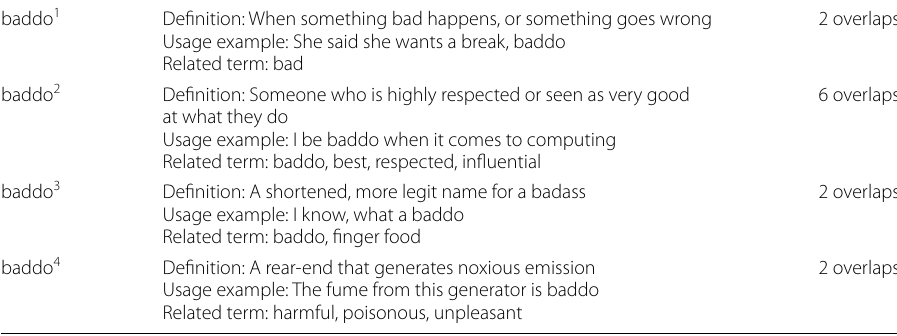
Table 7 Senses from IKB with overlap baddo